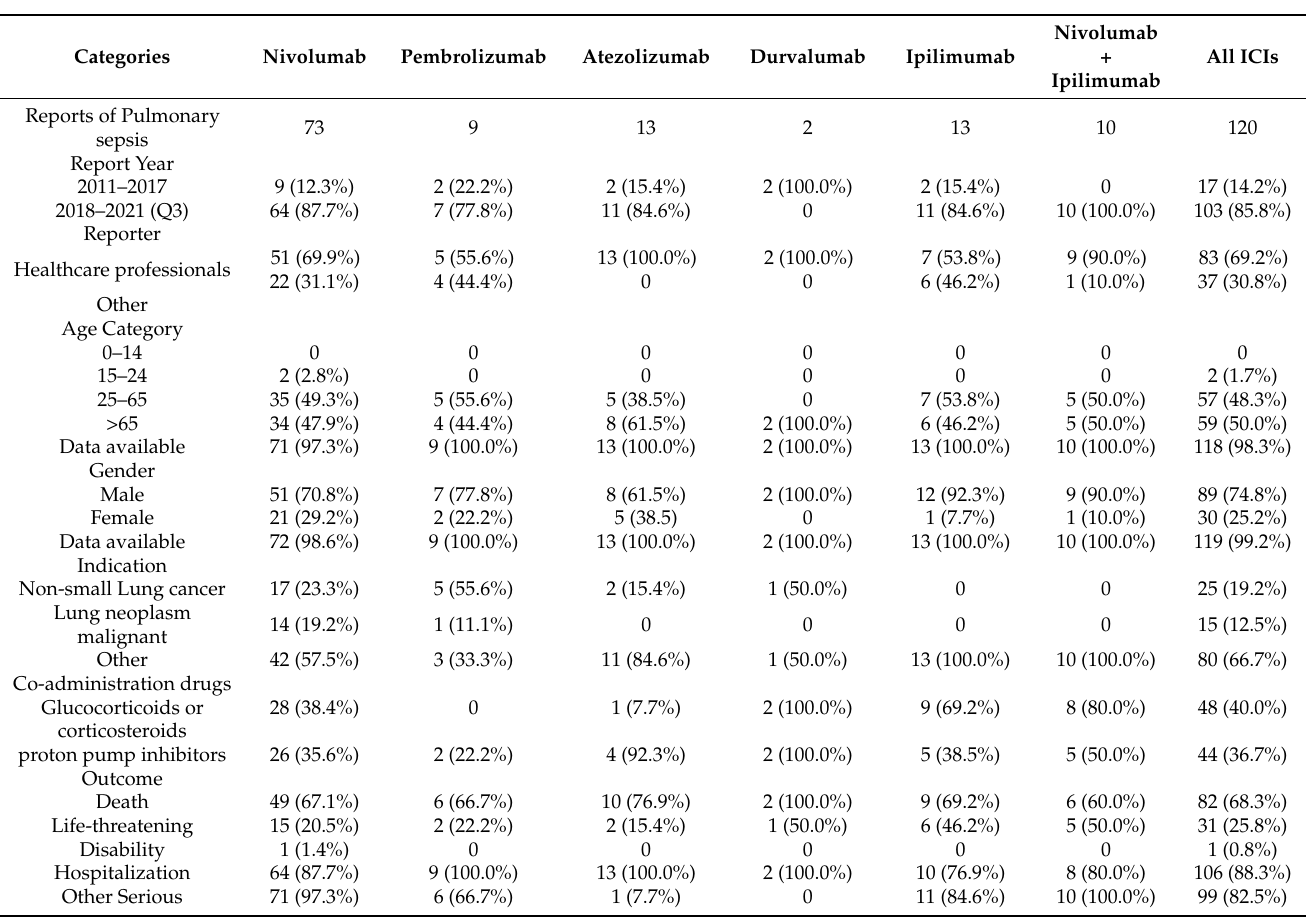
Table 2. Patient characteristics of pulmonary sepsis reports with immune checkpoint inhibitors in FAERS database.